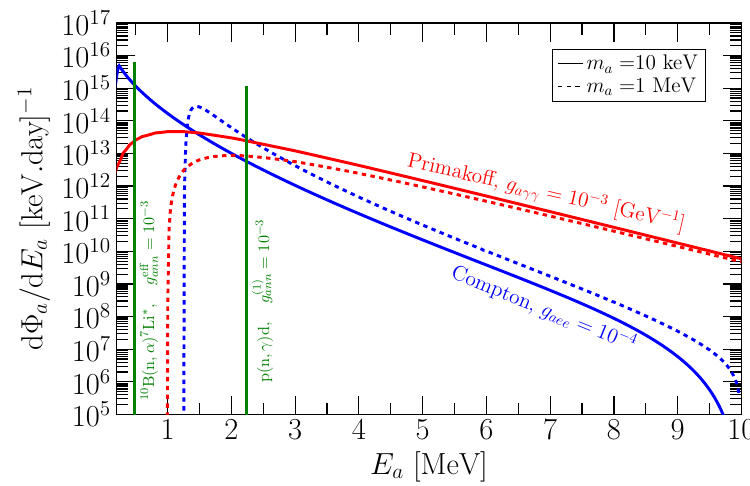
Figure 6 . Typical ALP flux generated in a 4 GW nuclear power plant through Primakoff and Compton-like scattering processes as well as through neutron capture in proton and 7 Li ∗ de- excitation (nuclear dominant M1 transition processes). Here we have assumed L = 10 m (reactor- detector distance), which is the value that we have used for the calculation of sensitivities in both current and future